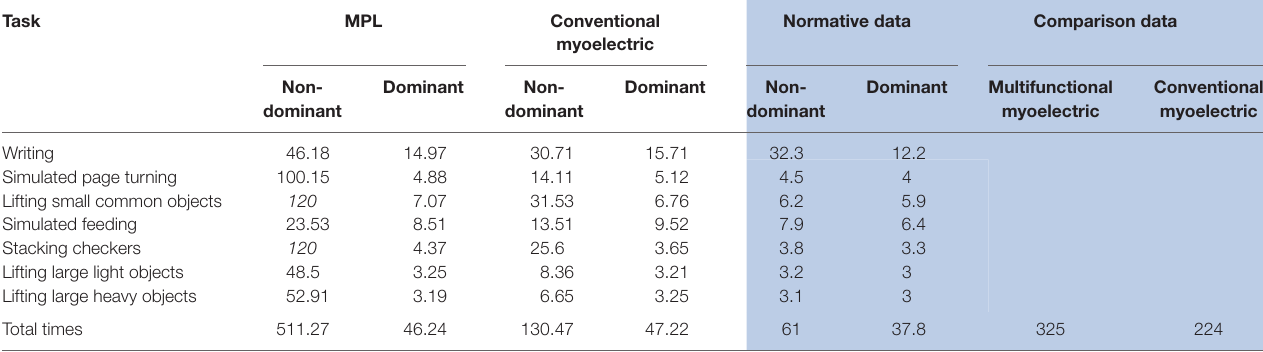
taBLe 1 | Jebsen-Taylor Hand Function Test ( JHFT ) results for TR02.